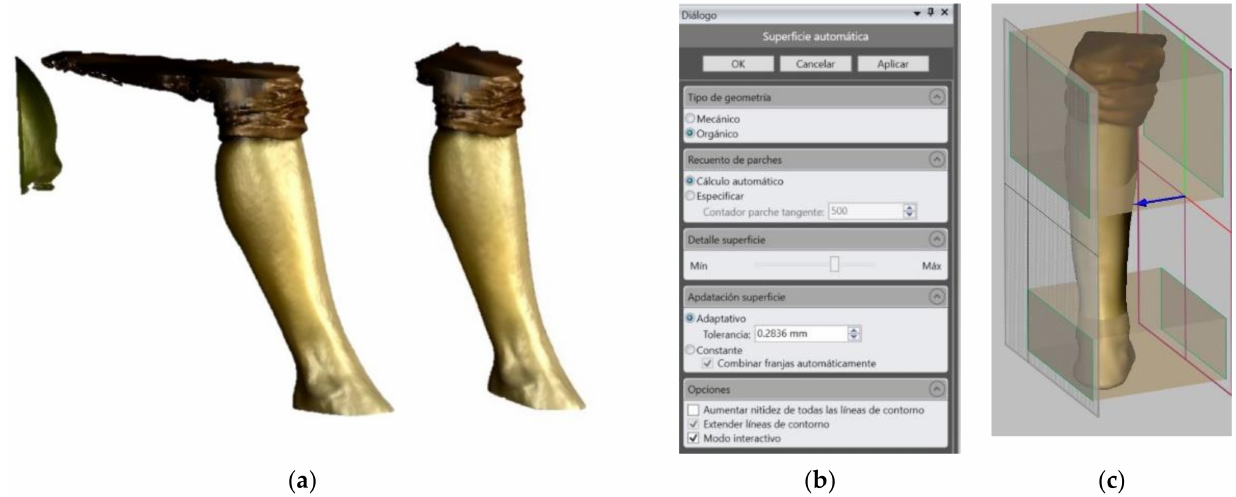
Figure 3. ( a ) Original and treated points cloud in Geomagic Software; ( b ) Mesh surface creation parameters; ( c ) Mesh